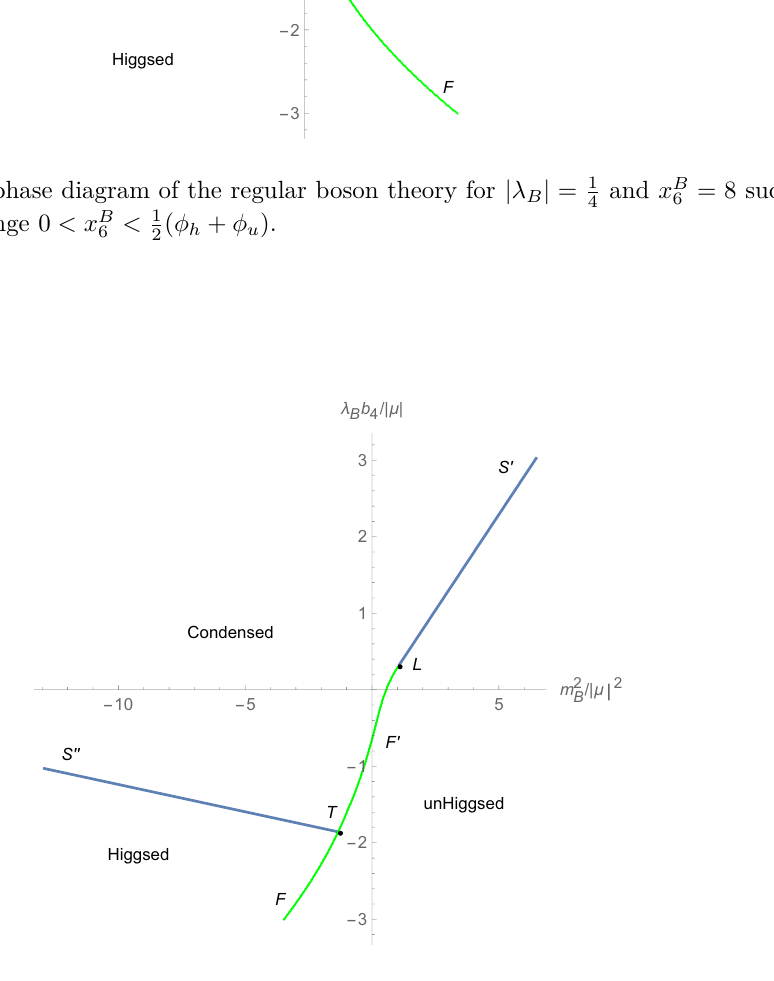
and x B = 11 such that it 6 4